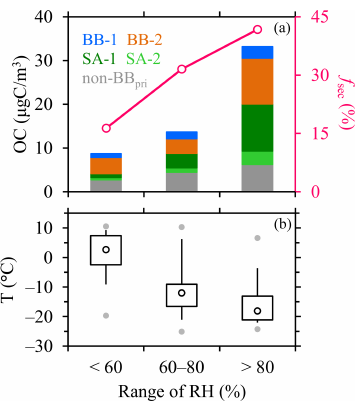
Figure 4. Comparisons of (a) OC source apportionment results (left axis), the contributions of PMF-based OC sec to OC ( f sec ; right axis), and (b) ambient temperatures across different RH ranges